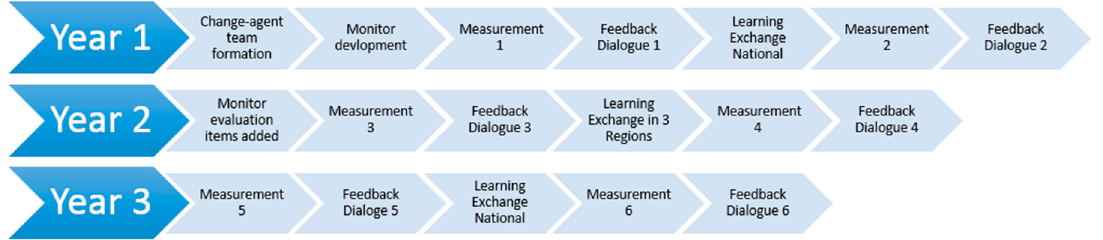
Figure 1. SP-EDO Study timeline summary of interventions and measurements.